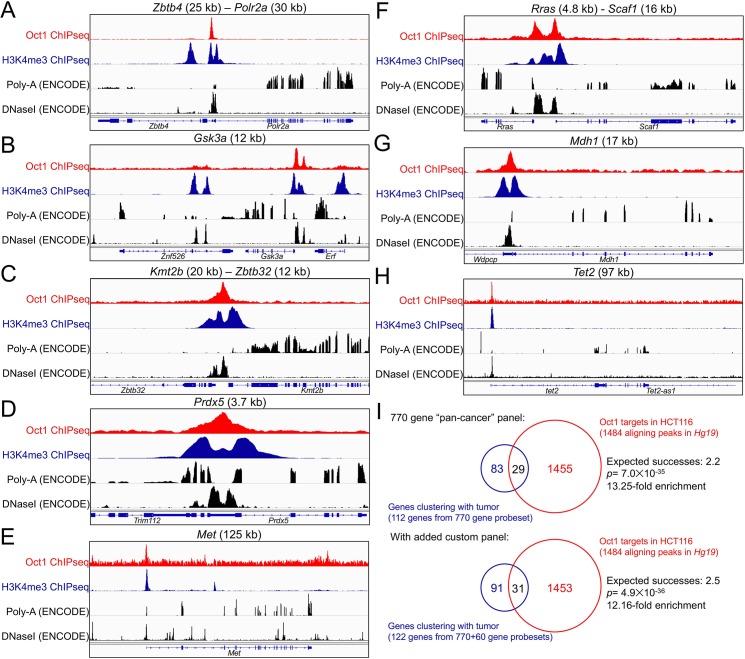
Putative Oct1 targets in human HCT116 cells significantly overlap with mouse genes differentially expressed between the two tumor models.(A) Example tracks (Hg19) are shown of Oct1 (red) and H3K4me3 (blue) ChIPseq using human HCT116 cells. The region of chromosome 17 corresponding to the Zbtb4 –Polr2a locus is shown. In black is shown ENCODE HCT116 RNAseq and DNaseI hypersensitivity at the same regions. (B) Similar data for Gsk3a. (C) Kmt2b –Zbtb32. (D) Prdx5. (E) Met. (F) Rras–Scaf1. (G) Mdh1. (H) Tet2. (I) Intersection of genes enriched from a PanCancer Pathways probeset with Oct1 targets identified by ChIPseq in HCT116 cells. A second analysis is also shown that includes additional genes enriched in a smaller custom probeset (S5 Table).